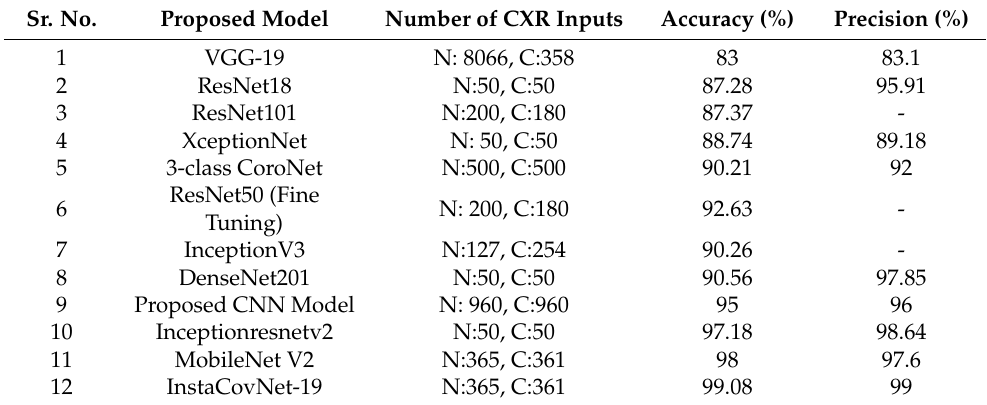
Table 3. Performance comparison for the proposed architecture with existing models. Sr.